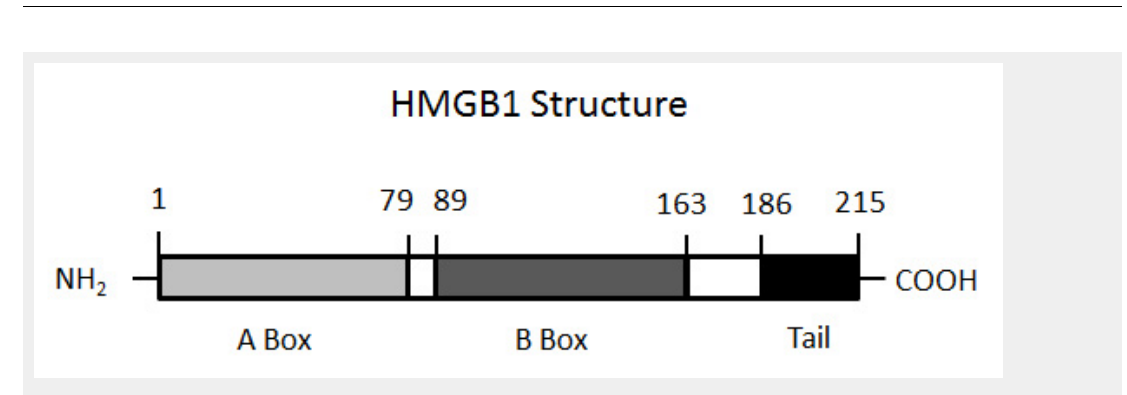
The structure of HMGB1. The figure illustrates the molecular structure of HMGB1, demonstrating the presence of two boxes (A and B) and the C-terminal tail.